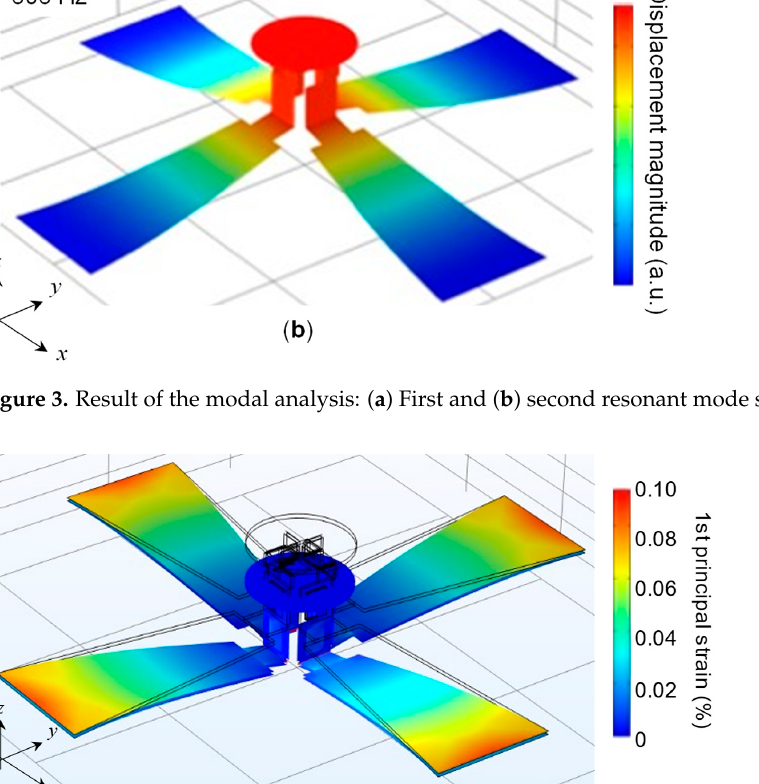
Figure 4. Result of the shock analysis: deformation shapes and strain contour plots when the for 0.3 for 0.3 ms.